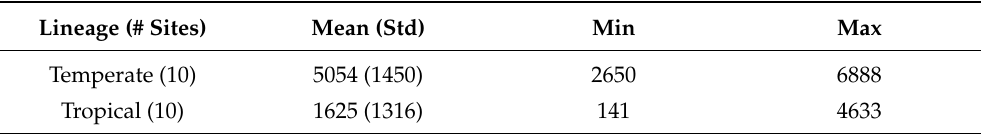
Table 3. Distribution of R. sanguineus s.l. lineages across elevation (in feet) in